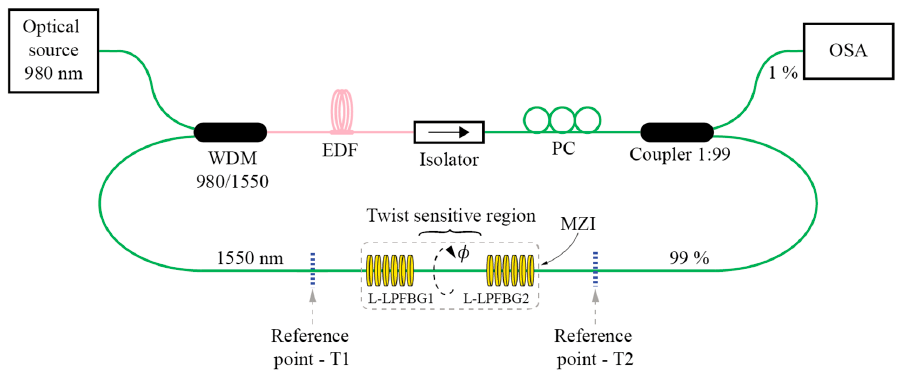
Figure 13. Torsion sensor employing Mach-Zehnder LPFBG in fiber ring laser configuration.